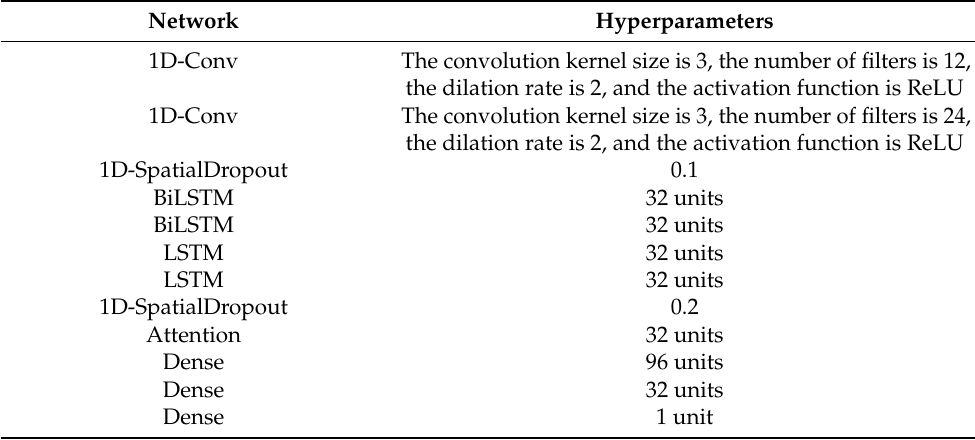
Table 2. Hyperparameter